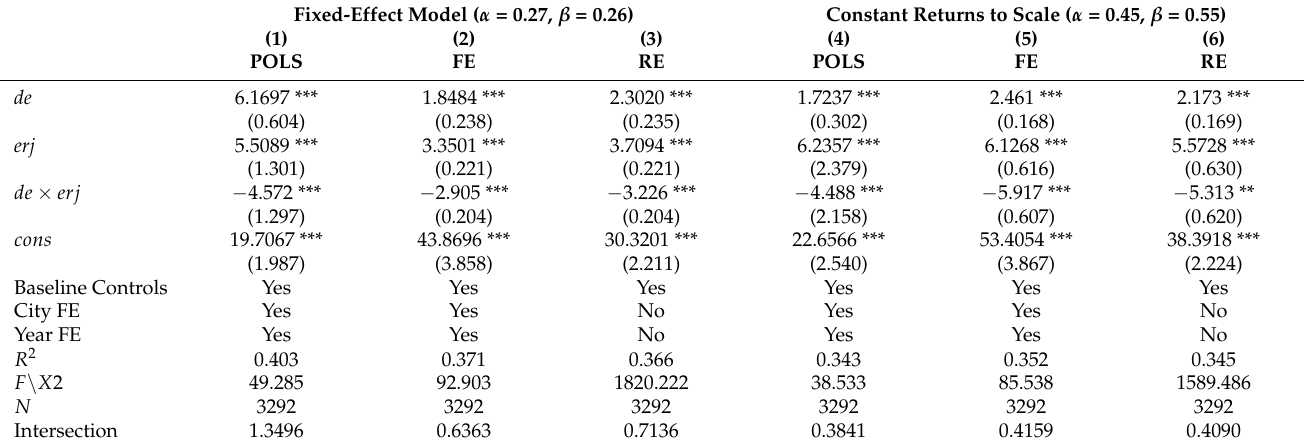
Table 11. Robustness Test 2: Replacement of input–output elasticity estimates. Fixed-Effect Model ( α = 0.27, β =